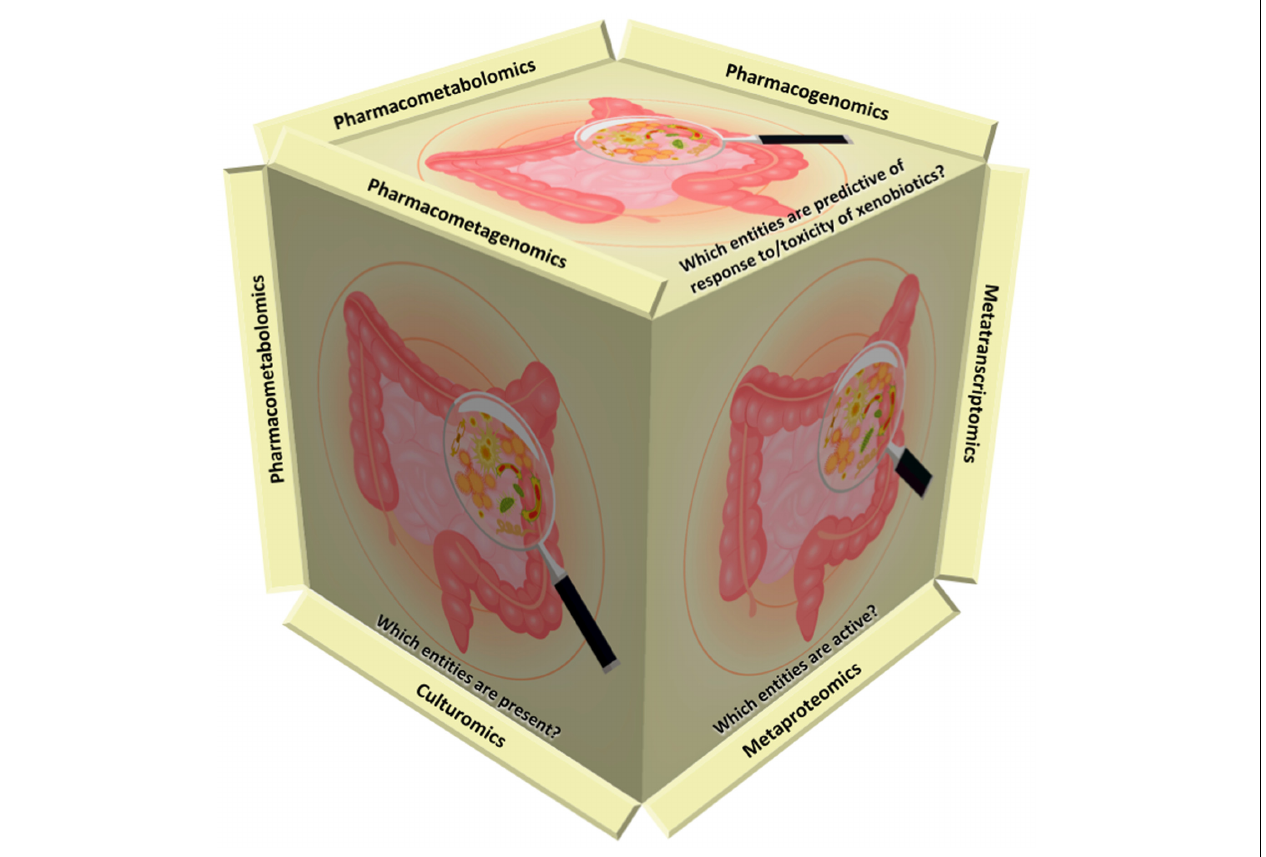
FIGURE 1 | Omics strategies complement each other to address current challenges. Metagenomics aims to address the question of “which entities are present?” via high-throughput sequencing or microarrays. Recently, culturomics has been introduced as a complementary approach to metagenomics. Viromics (viral metagenomics) studies aim to identify resident viruses. Metatranscriptomics and metaproteomics focus on “which entities are active?” Pharmacometabolomics (the later term used synonymously with pharmacometabonomics), pharmacogenomics and pharmacometagenomics aim to predict the response to and/or toxicity of xenobiotics on the basis of pre-dose